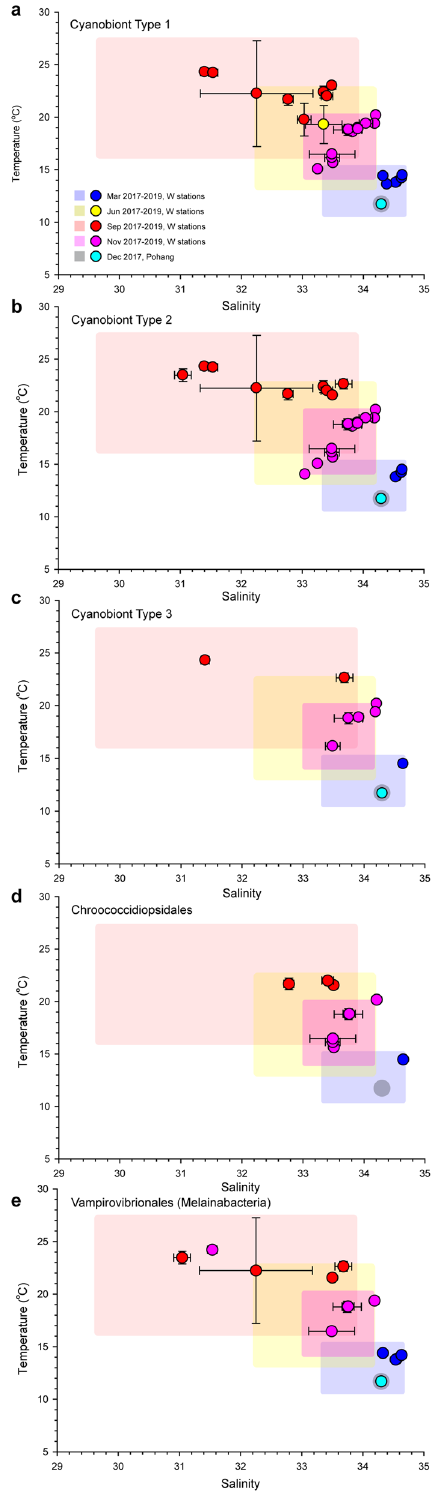
Figure 4. Temperature and salinity levels at stations where Ornithocercus cyanobionts were detected from isolated host cells sampled during different seasons (March, June, September, and November 2017–2019). ( a – c ) Stations where three genetic types of Synechococcales cyanobionts were detected; ( d , e ) Stations where Chroococcidiopsidales and Vampirovibrionales cyanobionts were detected. Square areas show the temperature- salinity range measured at the sampling stations. Error bars represent the standard deviations (SD) for temperature and salinity between surface and 30 m